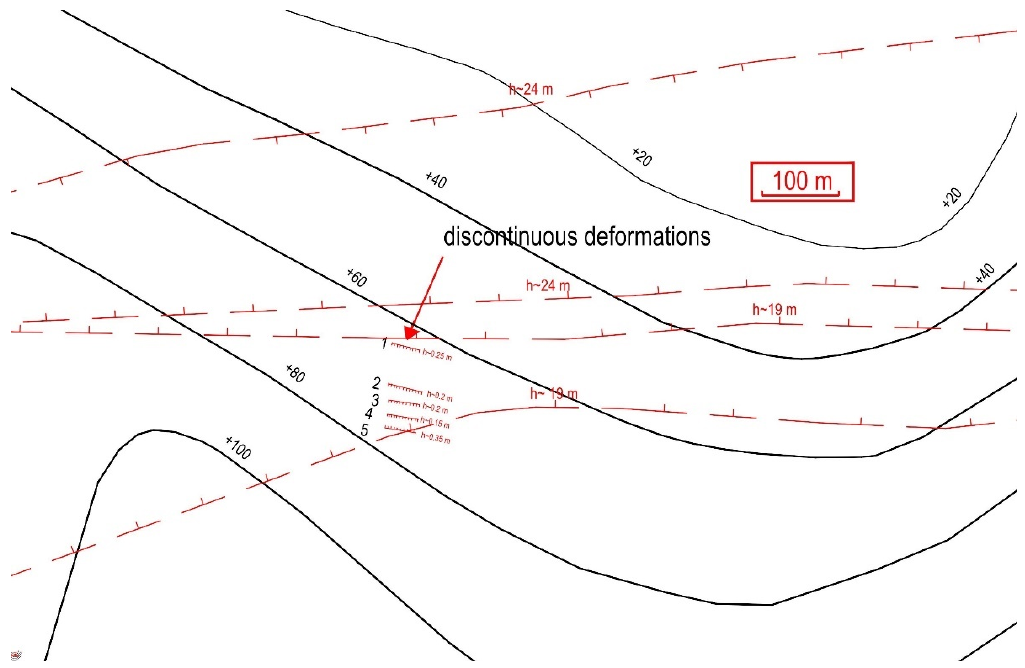
Figure 12. Map of the roof of Carboniferous layers with the location of linear discontinuous defor- mations.